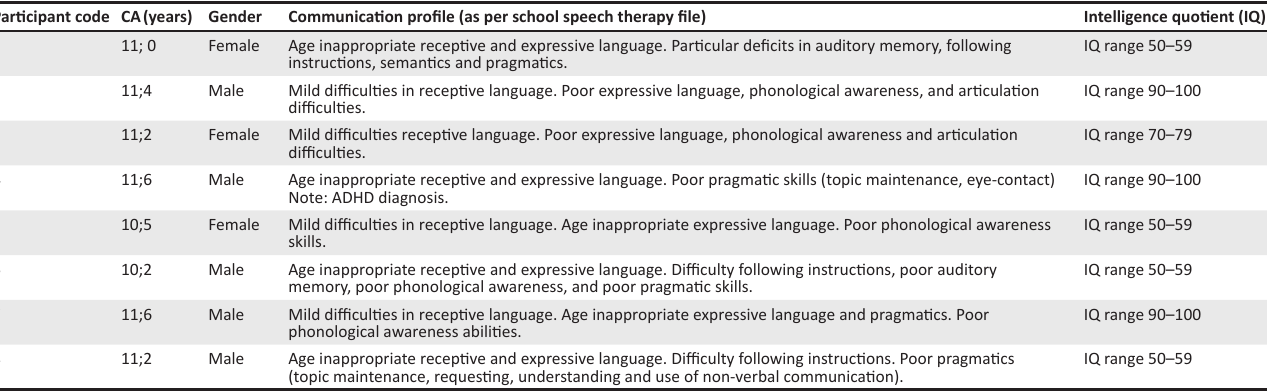
TABLE 1-A1: Description of